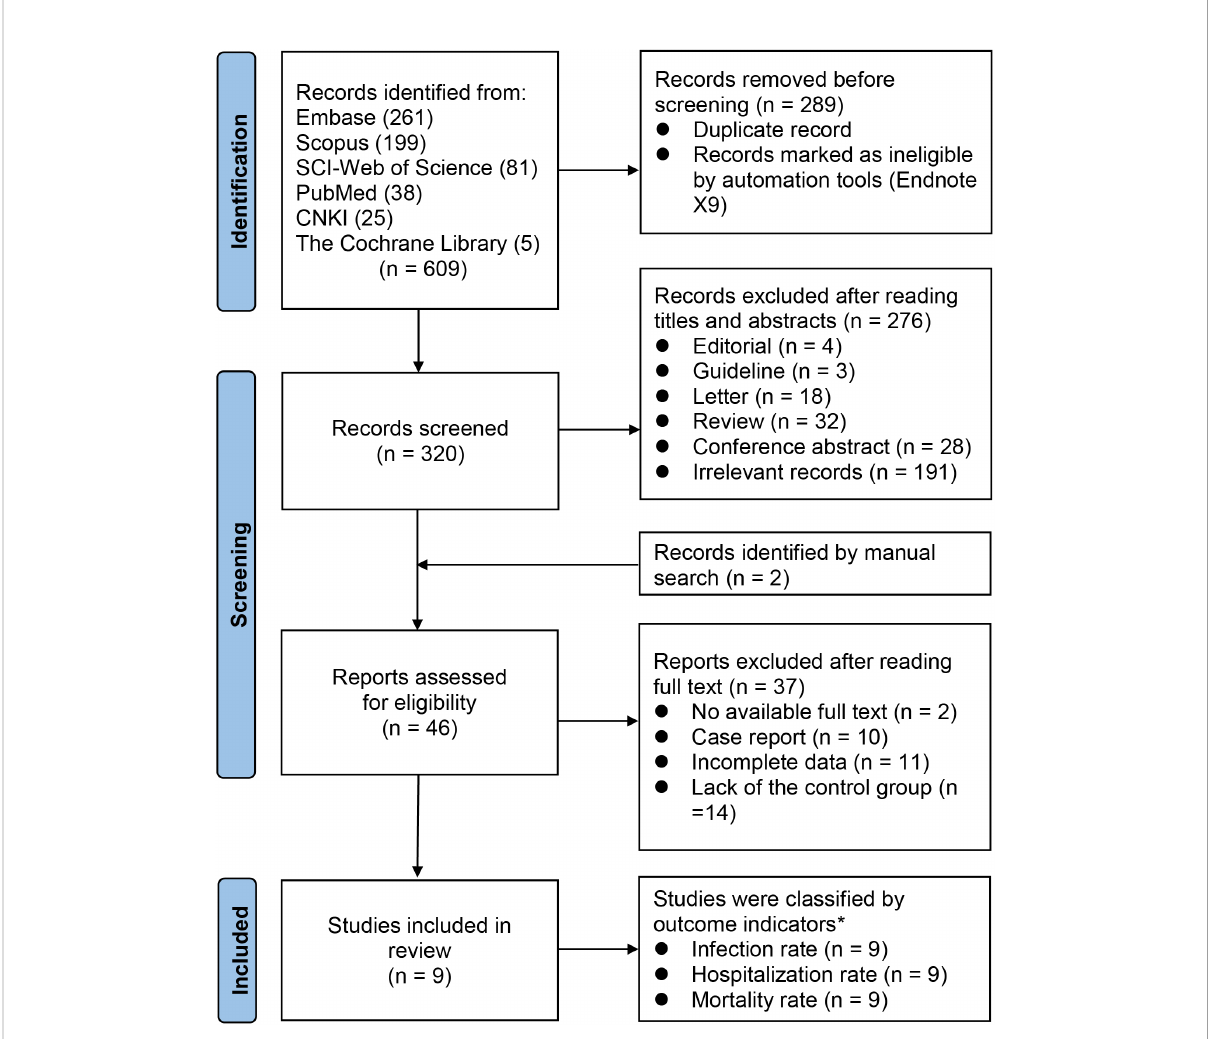
FIGURE 1 PRISMA fl ow chart for study selection. n , number; PRISMA , the Preferred Reporting Items for Systematic reviews and Meta-Analyses statement. *All included studies contain three